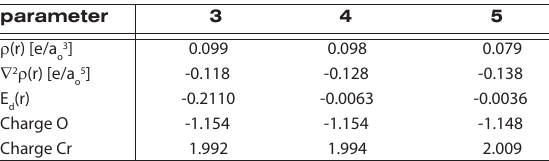
Table 4. Descriptive parameters at the point critical point in the bond path between Cr and O4; electronic density ρ (r), its Laplacian ∇ 2 ρ (r) and electronic energy density E (r). Also the values of the d atomic charges for the chromium and oxygen atoms are given. parameter